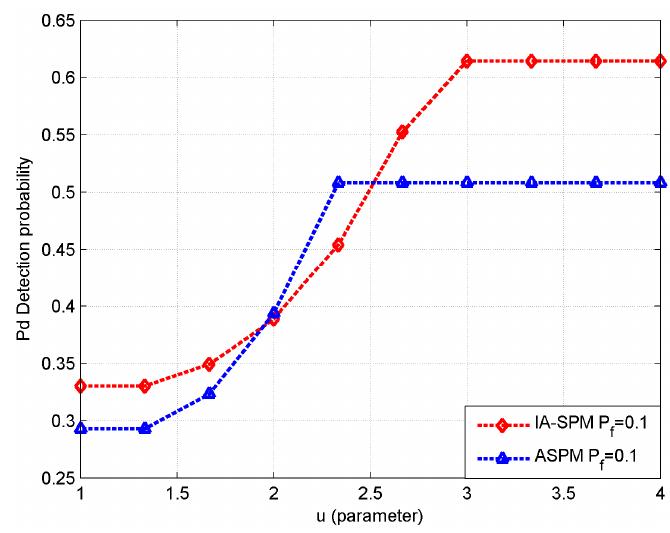
μ . Figure 5. Comparison of the IA-SPM vs. the TSPM with different µ .